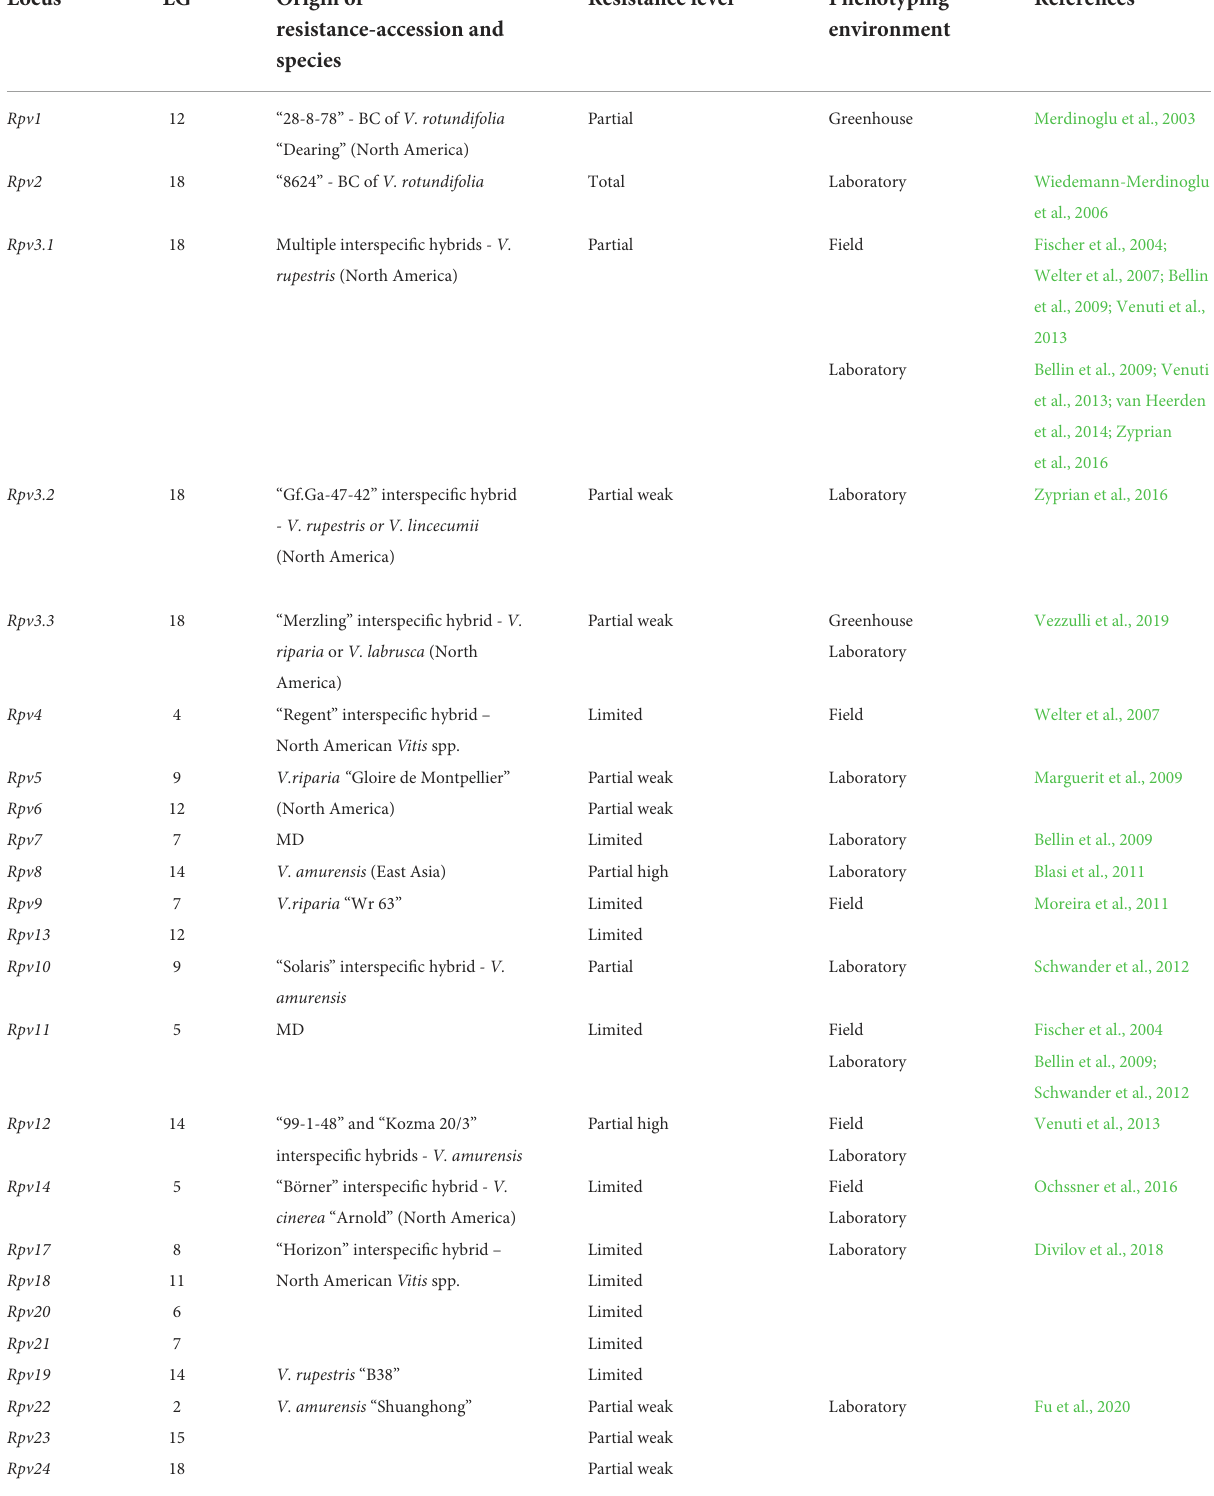
TABLE 1 Loci of resistance to P. viticola ( Rpv ) identified in grapevine. Resistance loci are listed with information about the grapevine accession/species of origin, the putative level of resistance associated with the locus and the environment of phenotyping utilized in the mapping